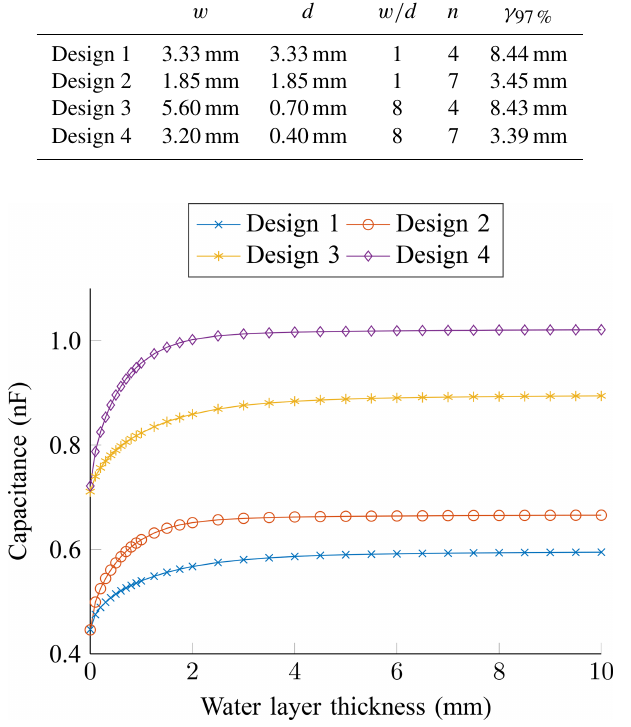
Figure 3. Simulated capacitance against water layer thickness for different electrode